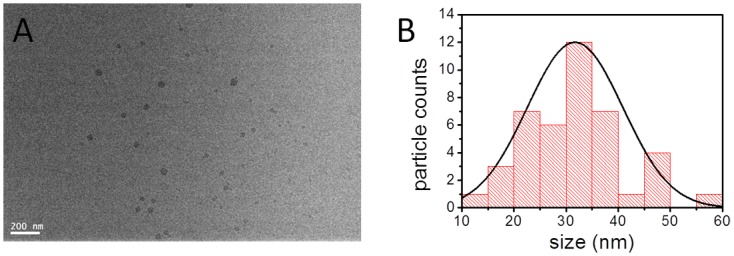
(A) In situ liquid cell TEM image of the 10 μM Abraxane solution sample, and (B) the size statistics of the albumin-bond paclitaxel particles obtained from (A). The curve in (B) is the Gaussian fit of the data.